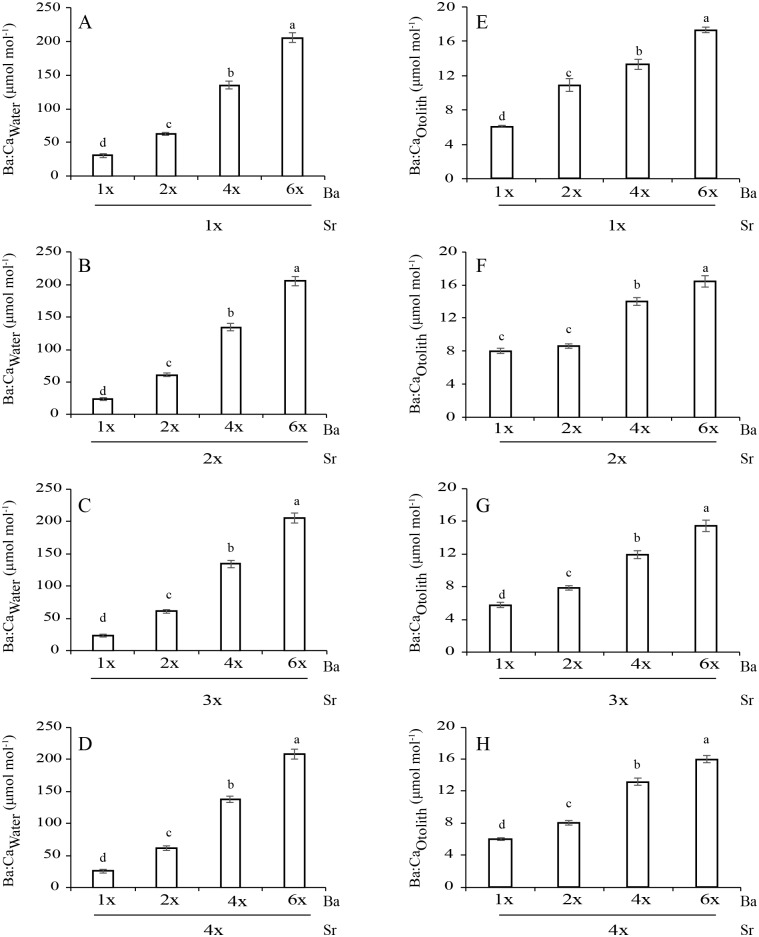
Measured Ba concentrations (mean±SD) in water (Ba:CaWater, A-D) and otoliths (Ba:CaOtolith, E-H) across treatments (two-way ANOVA, P<0.05).